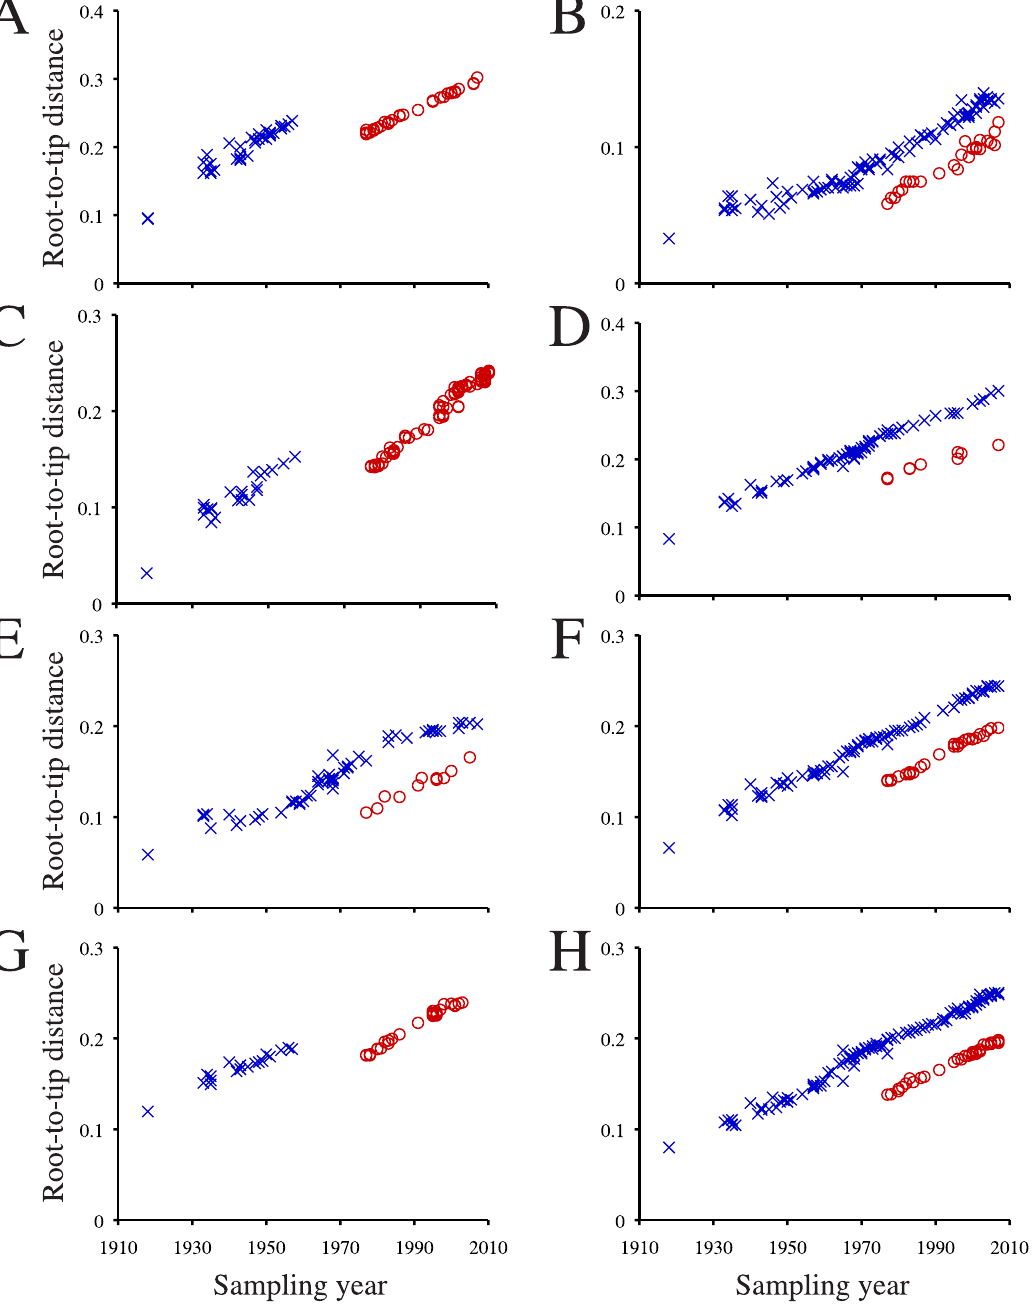
Figure 2. Root-to-tip genetic distance versus sampling year for human influenza virus segments. (A) HA, (B) M, (C), NA, (D) NP, (E), NS, (F) PA, (G) PB1, and (H) PB2 segments are shown. Pre-1977 H1N1, H2N2, H3N2 isolates are indicated with blue Xs, and re-emergent H1N1 isolates are indicated with red Os. doi:10.1371/journal.pone.0011184.g002 Table S2 Bayes factor model test on M segment.